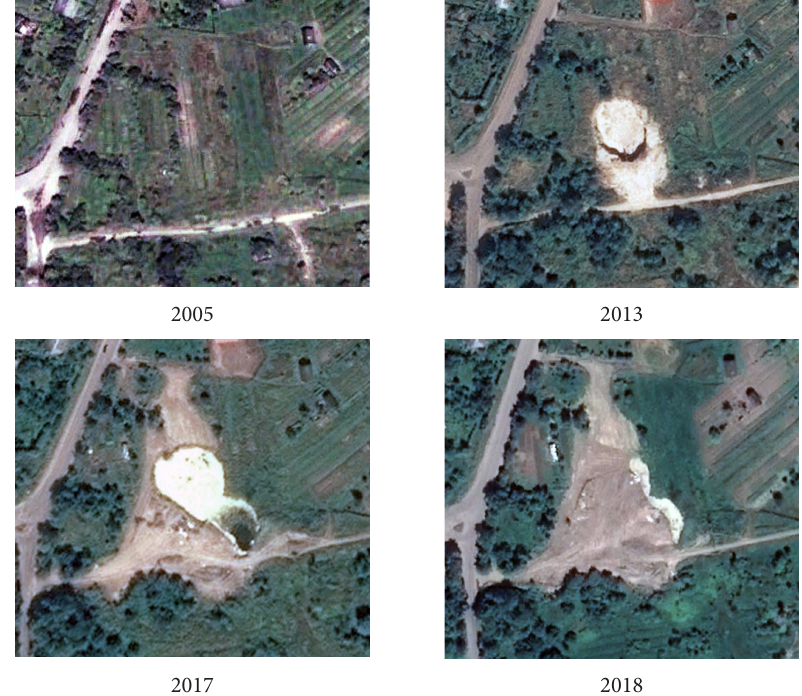
Figure 3. Dynamic of sinkholes’ formation 14 and 14a (49°2 ′ 35.64 ′′ 24°22 ′ 2.30 ′′ ) at the North kainite field on space